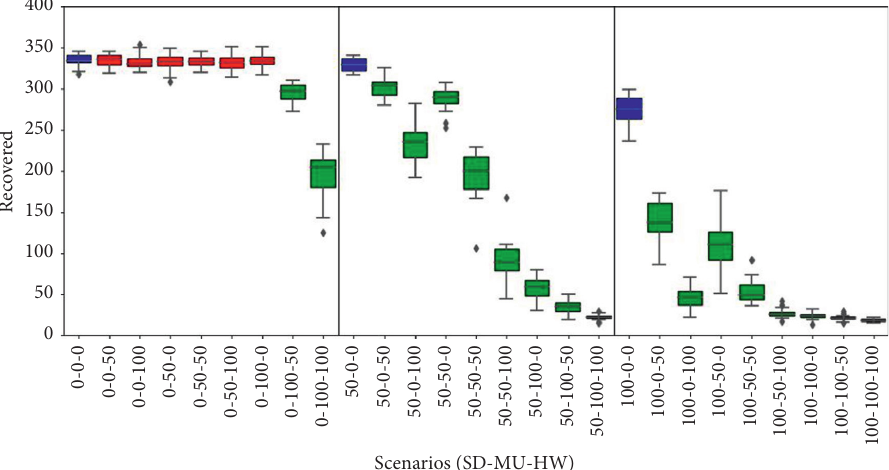
Figure 7: Recovered results. Box plots represent average and standard deviation of the cumulative count of agents that recovered from disease. Scenarios are labelled according to the willingness of agents to adhere to personal health habits such as social distance, mask user, or hands washer (SD%, MU%, and HW%). Baseline scenarios were defined varying the proportion of social distancers in the population assuming no agents adopt using masks or washing hands. In each panel, the baseline scenario is coloured blue (left, 0%-0%-0%; middle, 50%-0%-0%; right, 100%-0%-0%). Scenarios with statistical significant difference compared to their corresponding panel baseline (blue) are coloured green ( p value < 0 : 05); otherwise, they are coloured